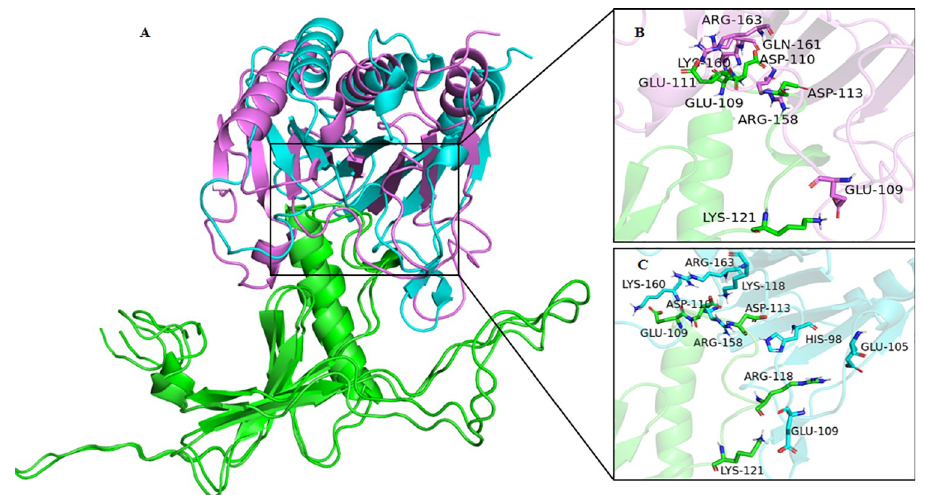
Fig 8. Representation of predicted mode of interaction of VPg with eIFiso4E and eIFiso4Ep. (A) Superimposition of docked VPg (pale green cartoon) with eIFiso4E (magenta cartoon) and eIFiso4Ep (cyan cartoon) complexes. (B) Interface residues between VPg and eIFioso4E. (C) Interface residues between VPg and eIFiso4Ep. Interface interaction residues are depicted as stick model with respective color codes. eIFiso4E. Comparison of docked VPg complexes with eIFiso4E and eIFiso4Ep showed a struc- tural change in the eIFiso4Ep structure, suggesting that the binding of VPg induces a confor- mational change in eIFiso4Ep (Fig 8A). Analysis of interface residues by PDBePISA between VPg and eIFiso4E, revealed that apart from the common interacting residues, phosphorylated form was observed to participate with additional salt bridge interactions with the VPg (Fig 8B and 8C). Interacting residues from VPg and eIFiso4E are sited in S1 Table.